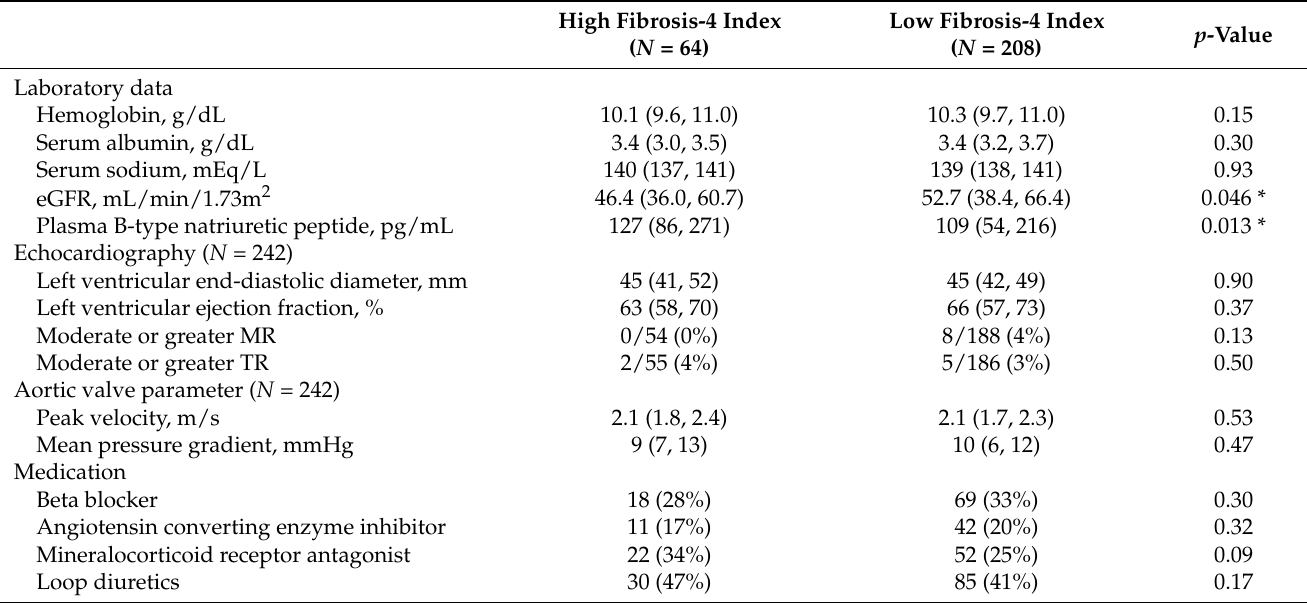
Table 2. Post-procedural clinical